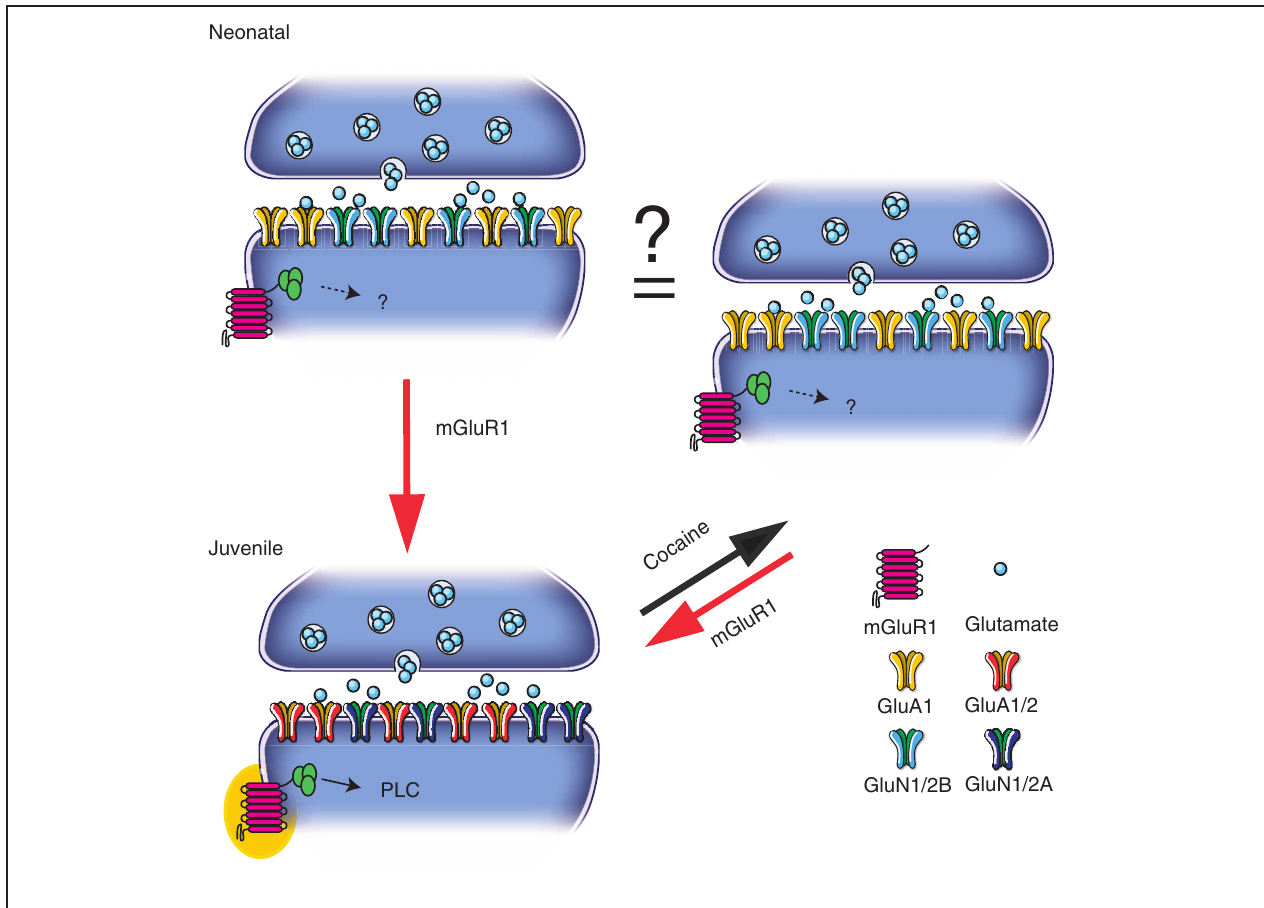
FIGURE 1 | During the first postnatal week (“Neonatal”), transmission is dominated by CP-AMPARs and GluN2B-containing NMDARs. Subsequently (“Juvenile”) mGluR1 receptors play a role in the synaptic insertion of CI-AMPARs and GluN2A-containing NMDAR. At juvenile synapses, a single cocaine injection exchanges CP-AMPARs for CI ones and